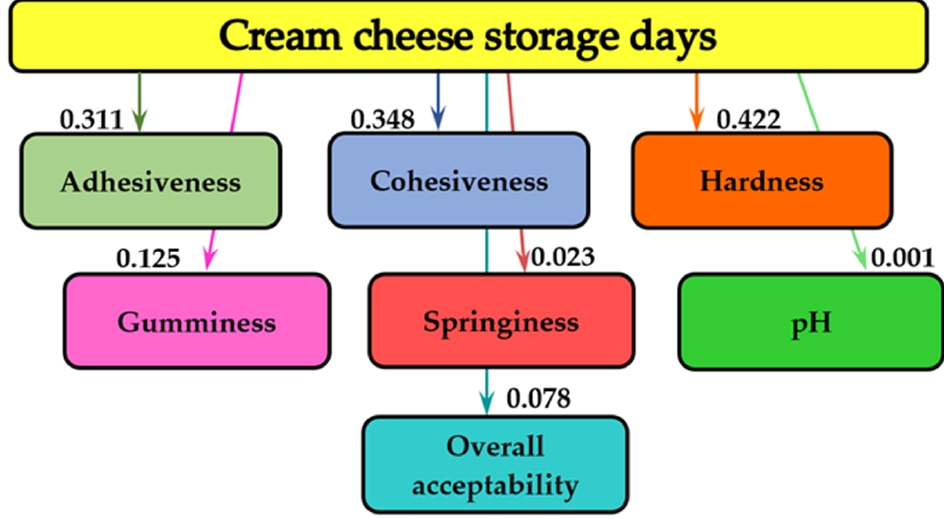
Figure 3. The informational analysis of the influence of storage days on the textural parameters, the pH and on the overall acceptability of cream cheese samples. pH and on the overall acceptability of cream cheese